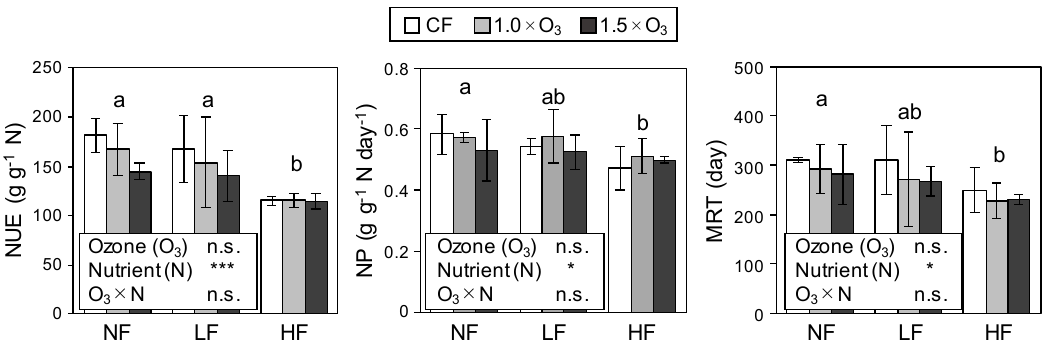
Figure 2. Nitrogen use e ffi ciency (NUE), nitrogen productivity (NP) and mean residence time of nitrogen (MRT) of Siebold’s beech seedlings in the second growing season. The seedlings were grown in nine treatments comprised of three levels of ozone treatments (CF: charcoal-filtered air; 1.0 × O 3 : 1.0 time ambient ozone concentration; 1.5 × O 3 : 1.5 times ambient ozone concentration) in combination with three levels of soil nutrient treatments (NF: non-fertilised; LF: low-fertilised; HF: high-fertilised). Each value is the mean ± standard deviation ( n = 3). Two-way ANOVA: * p < 0.05, *** p < 0.001, n.s. not significant. Di ff erent letter indicates significant di ff erence between the nutrient treatments (ozone treatments are pooled) with a p < 0.05.